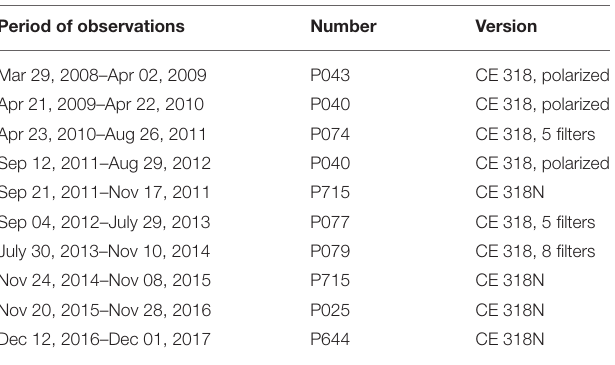
TABLE 1 | List of sun-photometers which used for aerosol measurements at the Kyiv AERONET site. Period of observations